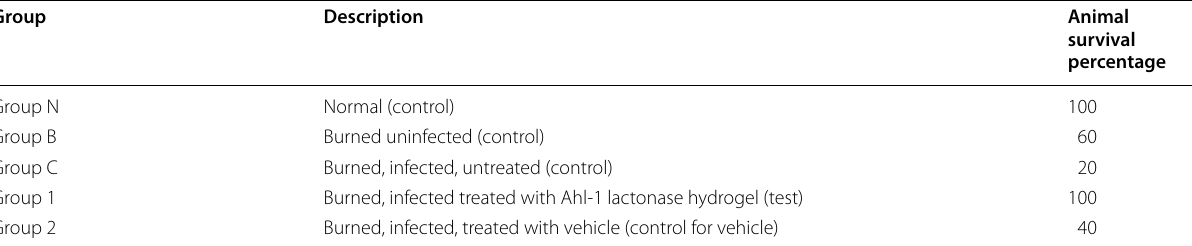
Table 3 Percentage of animals that survived in each group